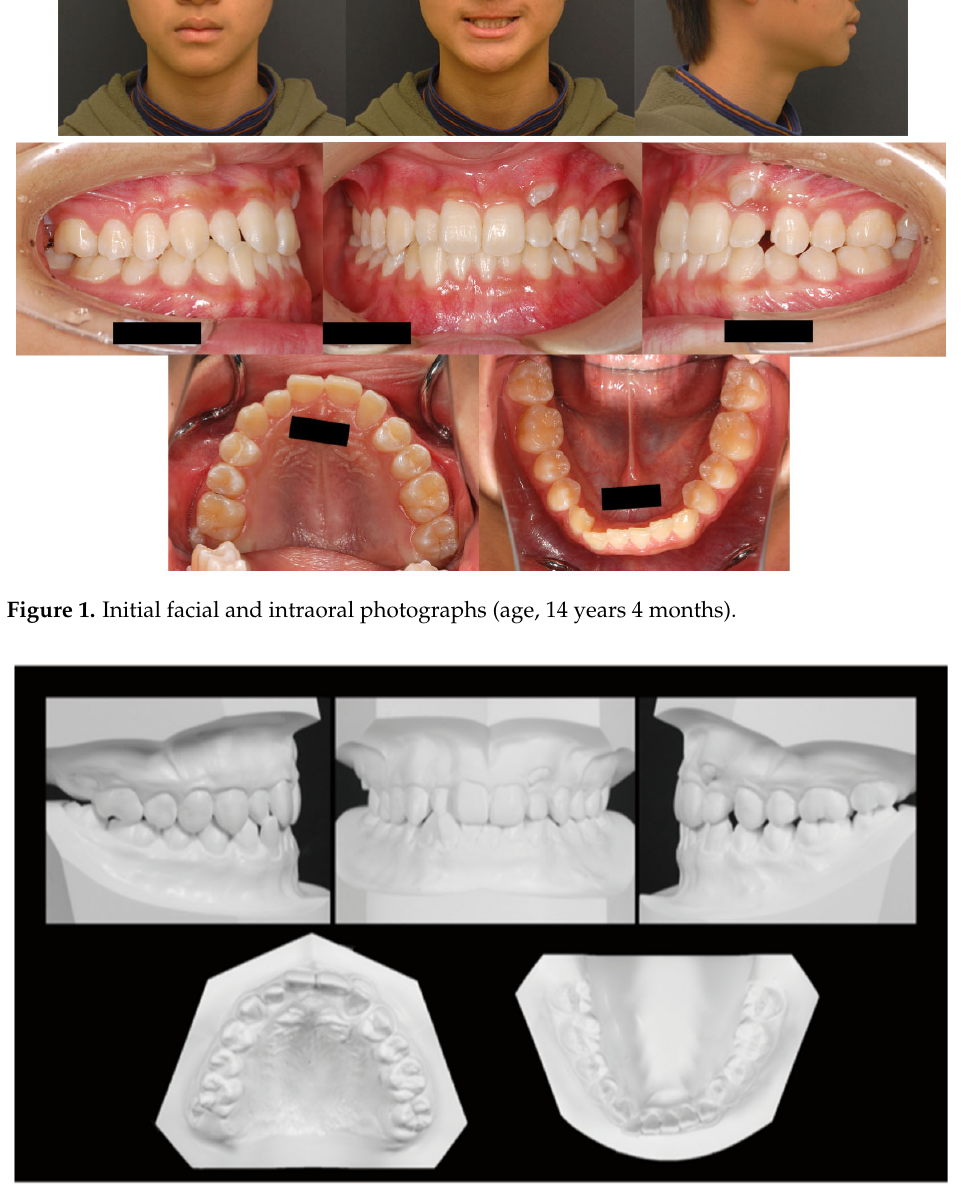
Figure 2. Initial dental casts (age, 14 years 4 months). Panoramic X ‐ ray and cone ‐ beam computed tomography (CBCT) images showed that the maxillary left canine had erupted ectopically due to eruption disturbance. The maxil ‐ lary left canine was mesially inclined with its crown near the labial root surface of the lateral incisor. The cusp of the canine was positioned more mesially than the lateral incisor